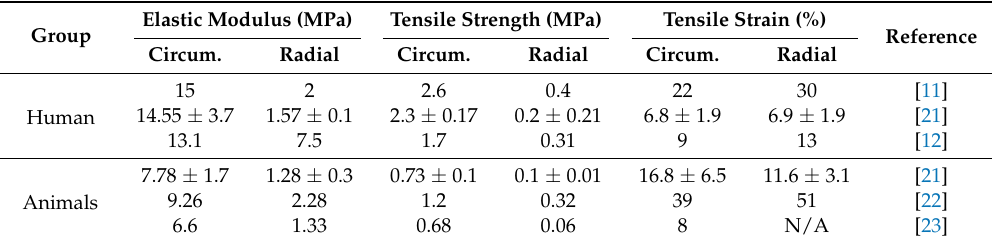
Table 1. Uniaxial mechanical properties of human and animal aortic